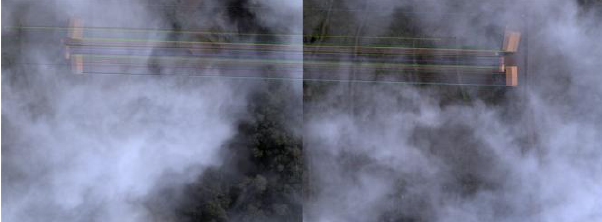
Figure 2: Matching clouded images